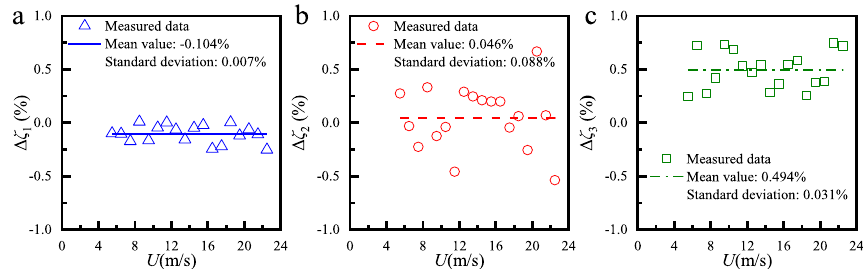
Fig. 18 Difference between identified damping ratios of first three vertical bendings using SSI-COV and EWT-HT: a First-order; b Second-order; c Third-order